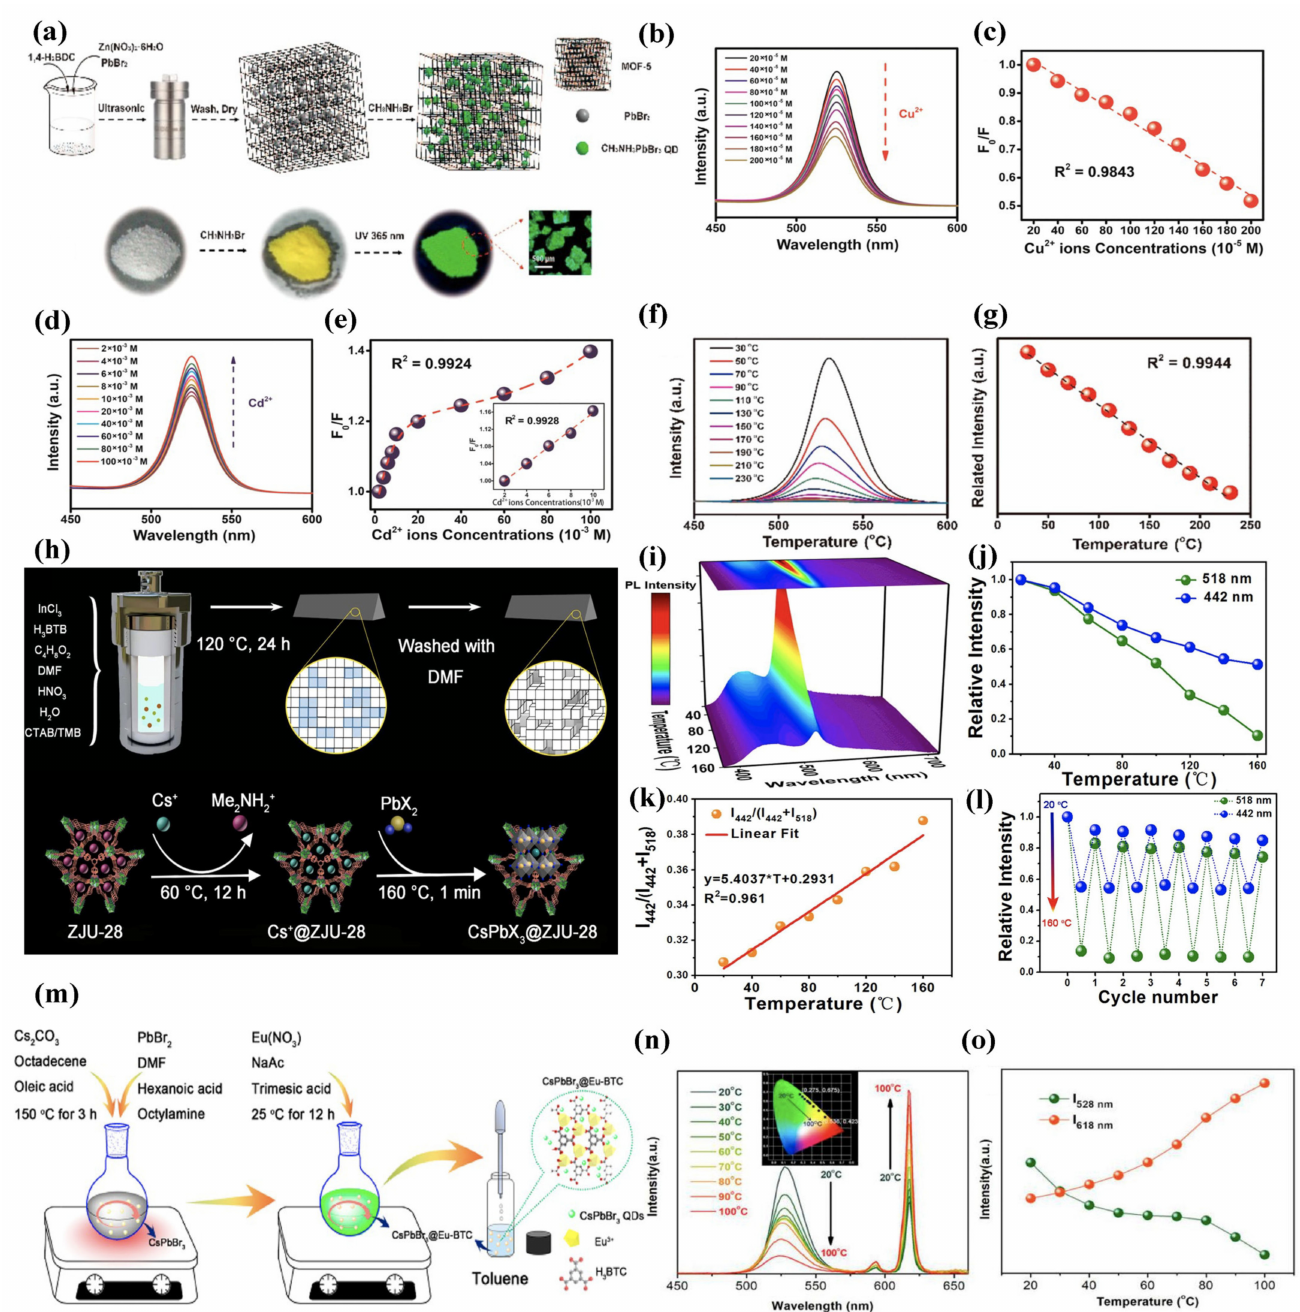
Figure 5. ( a ) Schematic diagram of the two-step approach to CH 3 NH 3 PbBr 3 @MOF-5 composites. The first step in- cluded the synthesis of PbBr 2 @MOF-5 precursor by a solvothermal method, and the second step involved the addition of CH 3 NH 3 Br solvent for the final CH 3 NH 3 PbBr 3 @MOF-5. Illustrative images of the PbBr 2 @MOF-5 precursor, the CH 3 NH 3 PbBr 3 @MOF-5 composite (under daylight and 365 nm UV-light excitation) and its fluorescence microscope morphology. ( b ) PL spectra of CH 3 NH 3 PbBr 3 @MOF-5 composites depending on various Cu 2+ ion concentrations. ( c ) Stern–Volmer plot for the F 0 /F values and different Cu 2+ ion contents. ( d ) PL spectra of CH 3 NH 3 PbBr 3 @MOF-5 composites depending on various Cd 2+ ion concentrations and ( e ) Stern–Volmer plot for the F 0 /F values and different Cd 2+ ion contents. ( f ) PL spectra of CH 3 NH 3 PbBr 3 @MOF-5 composites depending on increasing temperature from 30